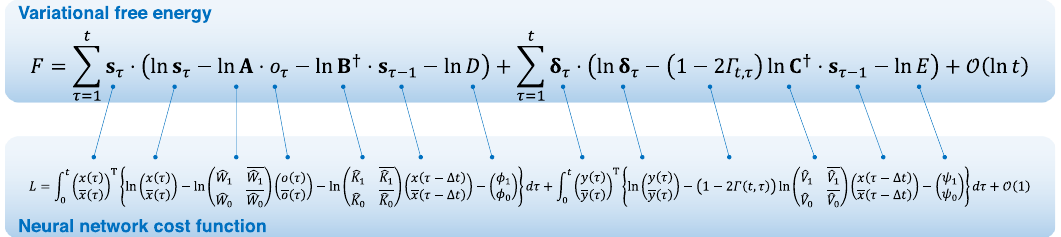
Fig. 3 Mathematical equivalence between variational free energy and neural network cost functions, depicted by one-to-one correspondence of their components. Top: variational free energy transformed from Eq. (5) using the Bayes theorem. Here, B y ¼ B T diag ½ D (cid:3) (cid:2) 1 and C y ¼ C T diag ½ E (cid:3) (cid:2) 1 indicate the inverse mappings, and D and E are the state and decision priors. Bottom: neural network cost function that is a counterpart to the aforementioned variational free energy. In this equation, ^ W l : ¼ sig ð W l Þ , ^ K l : ¼ sig ð K l Þ , and ^ V l : ¼ sig ð V l Þ (for l ¼ 0 ; 1) indicate the sigmoid functions of synaptic strengths. Moreover, ϕ l and ψ l are perturbation terms that characterise the bias in fi ring thresholds. Here, ϕ l : ¼ ϕ l ð W l ; K l Þ ¼ h l (cid:2) ln ^ W l 1 ! ^ V W K ψ : ¼ ψ V m is a function of V l . When ^ ω i : ¼ sig ð ω i Þ is the sigmoid function of ω i , ω i (cid:5) ln ^ ω i (cid:2) ln ^ ω i holds for an arbitrary ω i . l and l , while l Þ ¼ l (cid:2) ln l 1 l l ð Using this relationship, Eq. (7) is transformed into the form presented at the bottom of this fi gure. This form of cost functions formally corresponds to variational free energy expressed on the top of this fi gure. Blue lines show one-to-one correspondence of their